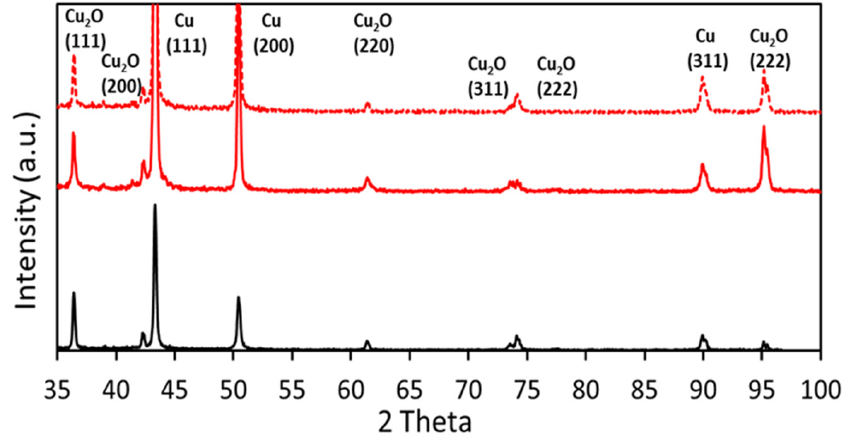
Figure 5. XRD of 18 mM HCl copper foams with added 10 mM urea (black, at the bottom), 100 mM urea in deposition bath (solid red, in the middle), or dip-coated from a 100 mM urea neutral aqueous solution (dotted red, at the top).